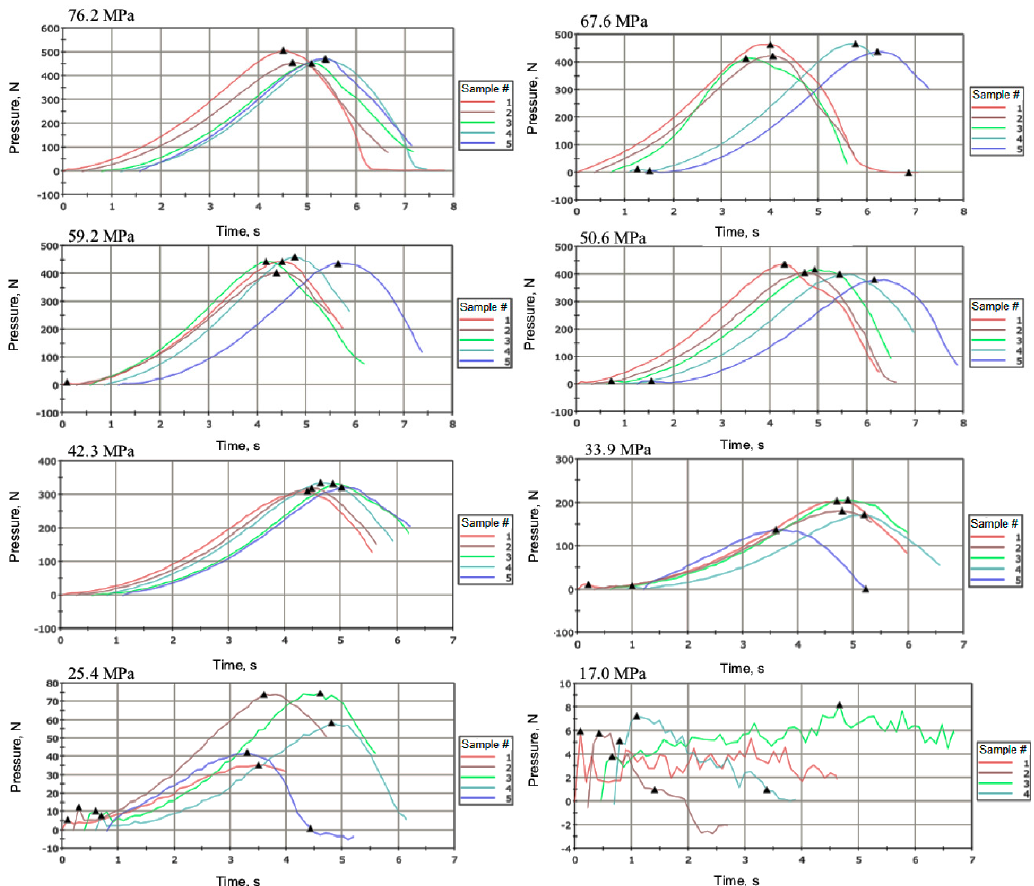
Energies 2018 , 11 , x FOR PEER REVIEW Figure 1. The response to the compressive load of carbonized refuse-derived fuel (CRDF) pellets produced with different pressures ranging from 17.0 MPa to 72.6 MPa. Black triangles signify the crack point of the pellet sample, and thus the maximum compressive strength of the densified material.